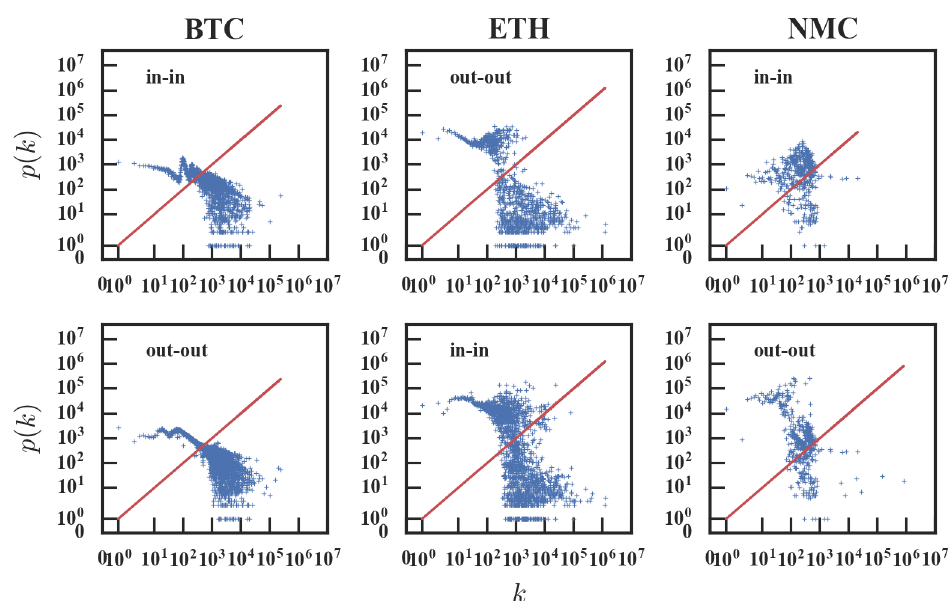
Fig 8. A comparison of the average degree of nodes’ neighbors and the degree of nodes. The red line indicates the degree of the node and the average degree of the node’s neighbors is equal. In networks without degree correlations, the h k nn i is constant. However, for Bitcoin and Ethereum, h k nn i is a decreasing function, while for Namecoin h k nn i is